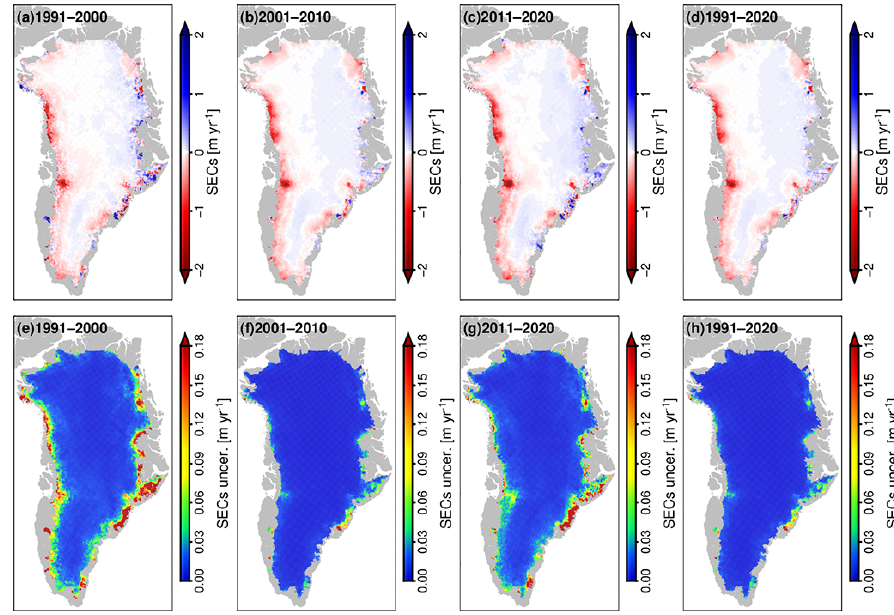
Figure 5. Maps of long-term SECs and their uncertainties from the combined elevation time series over the periods of (a, e) 1991–2000, (b, f) 2001–2010, (c, g) 2011–2020, and (d, h) 1991–2020.